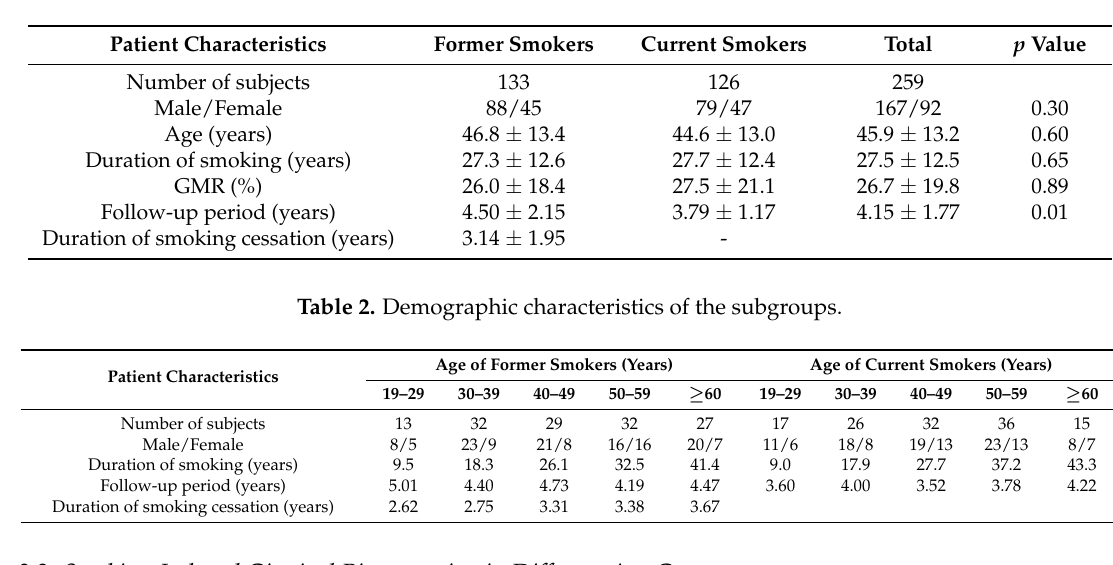
Table 1. Demographic characteristics of the patients at baseline.